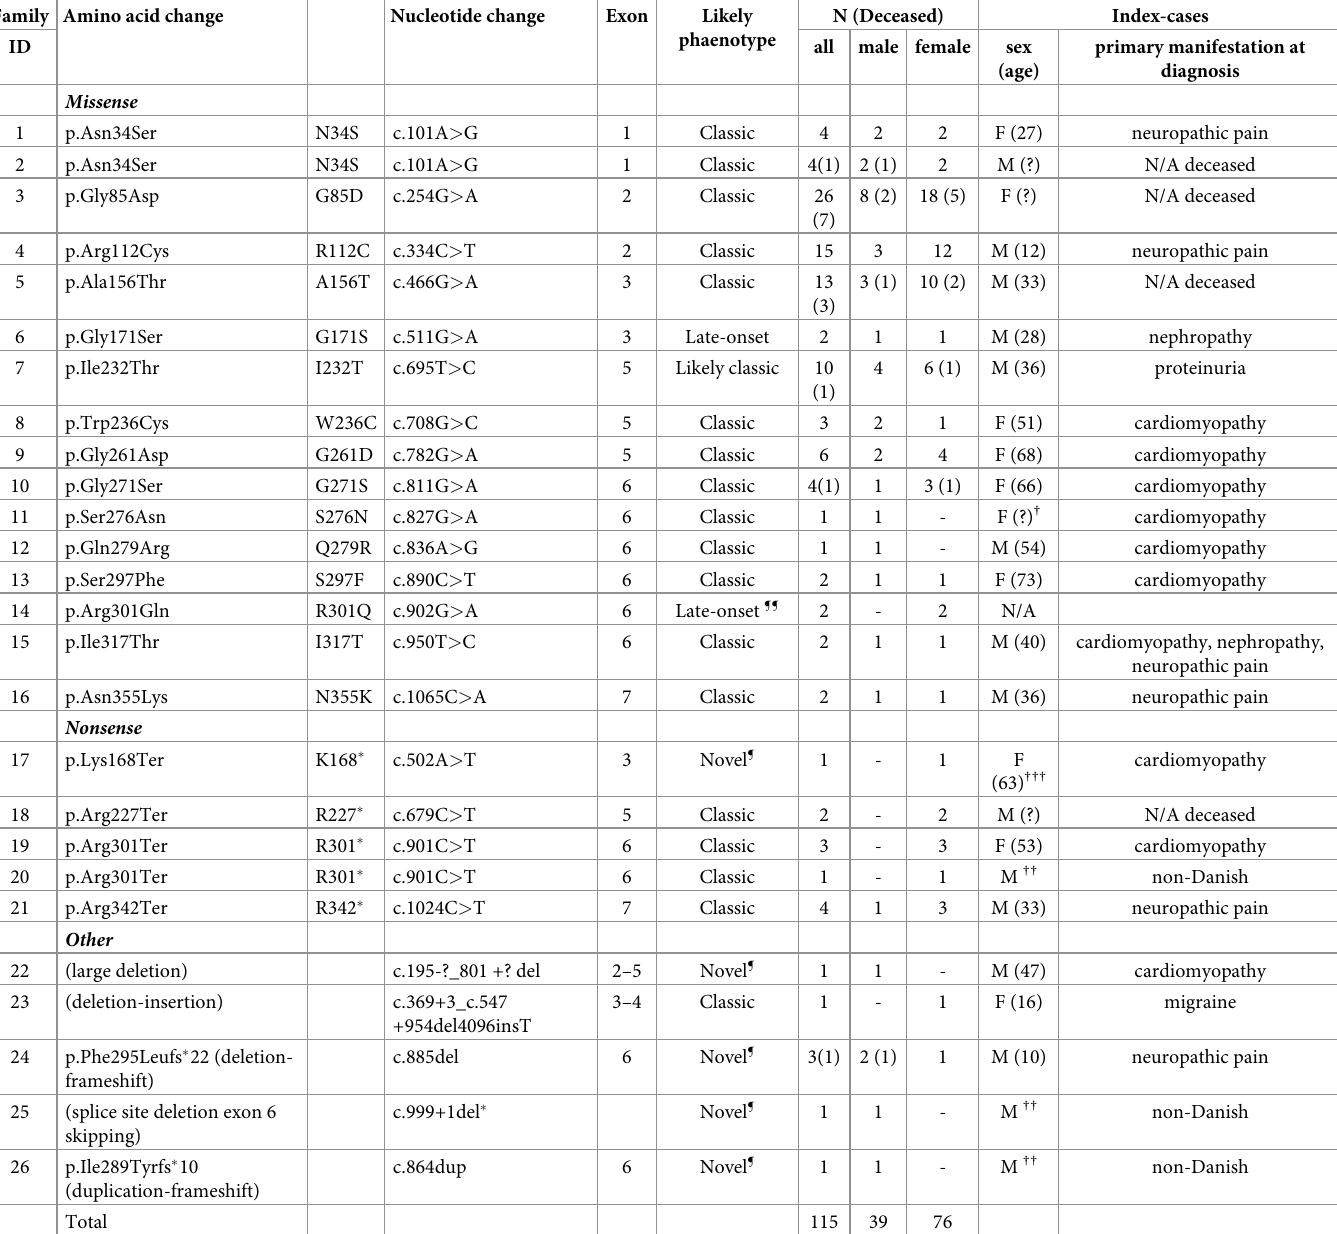
Table 1. The 26 families, their 115 Fabry disease patients and their corresponding GLA -gene variants of the Danish Fabry disease register. Type of the GLA gene pathogenic variants, protein nomenclature, colloquial nomenclature, coding sequence (according to http://varnomen.hgvs.org), site of mutation and genotype